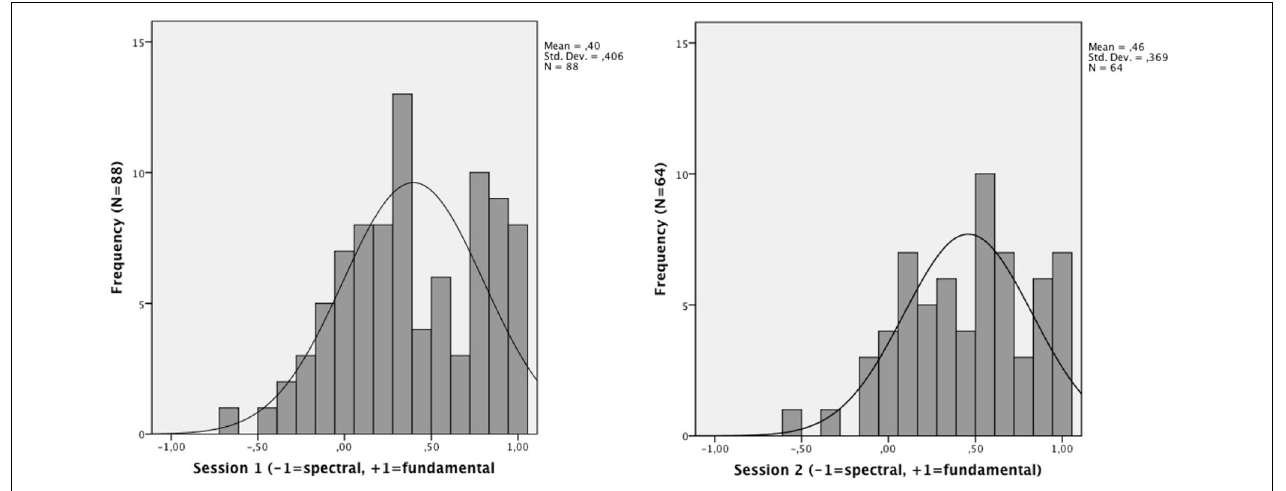
FIGURE 2 | Distribution of δ p during the first session and second session of the psychoacoustic task.